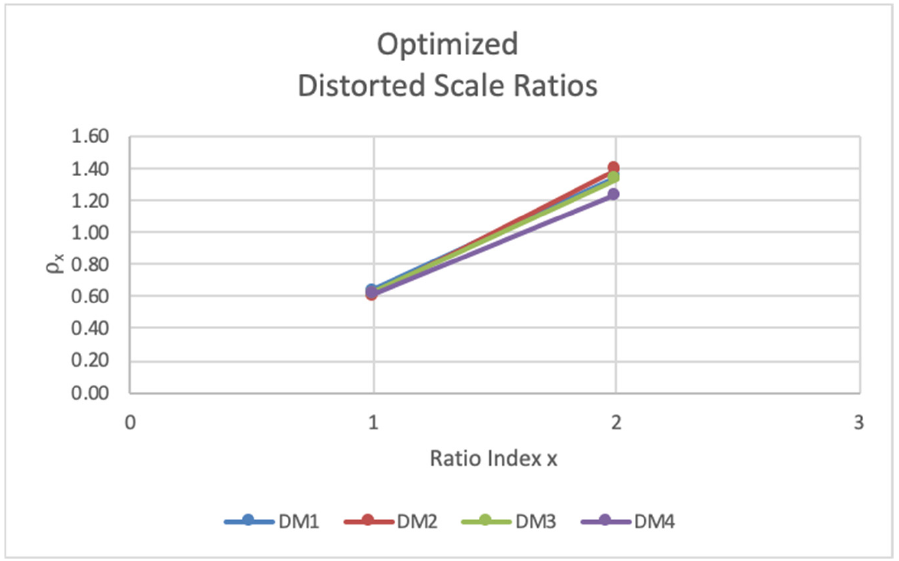
Figure 6. Optimized distorted scale ratios between decision makers.